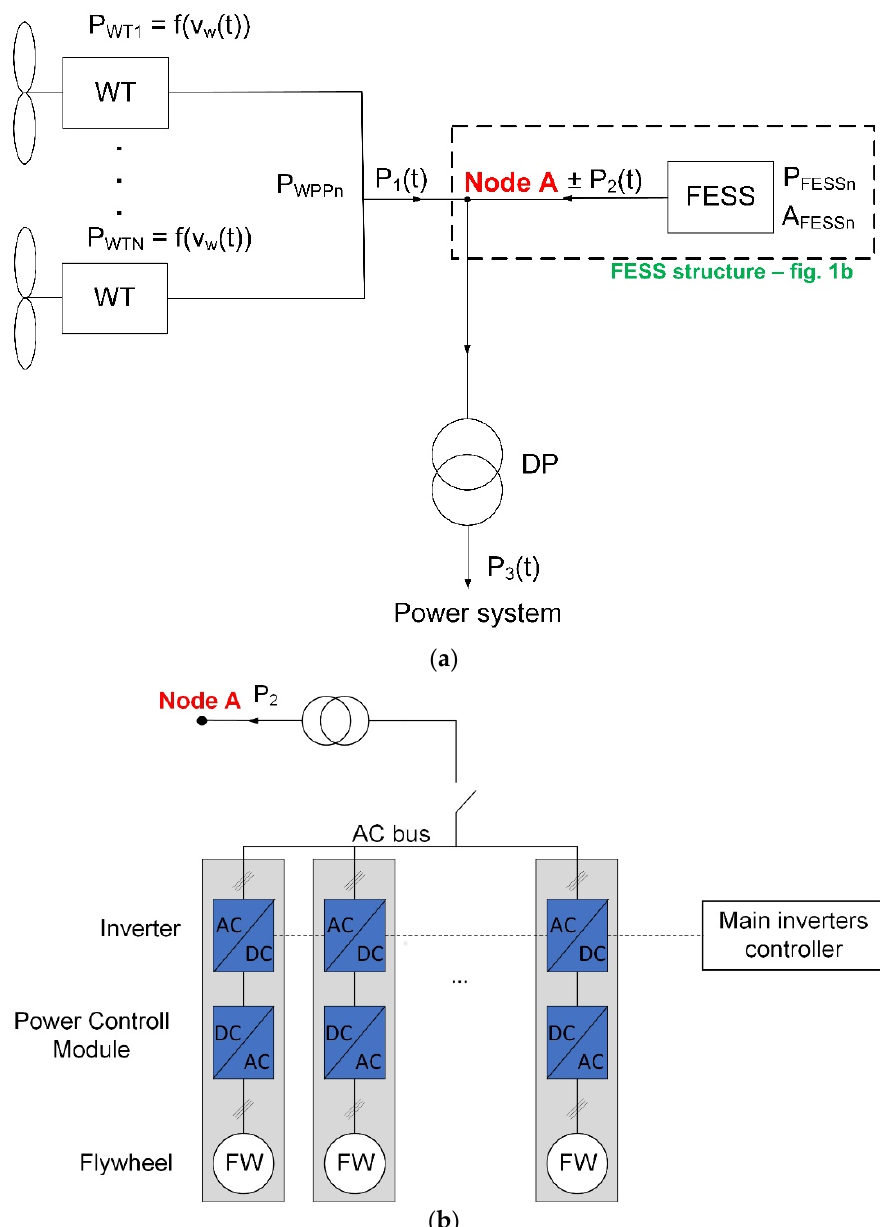
Figure 1. ( a ) Electrical diagram and power flow directions in the wind power plant–energy storage system (WPP-FESS) arrangement (P WT1 , P WT2 , …, P WTN —capacity of wind turbines in the power